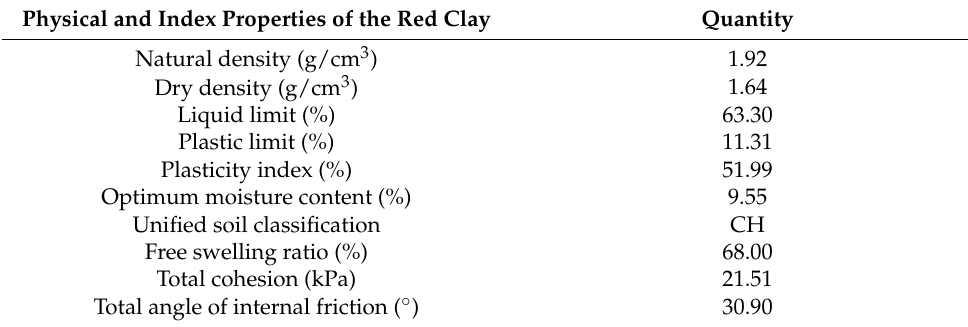
Table 1. Properties of the tested red clay.